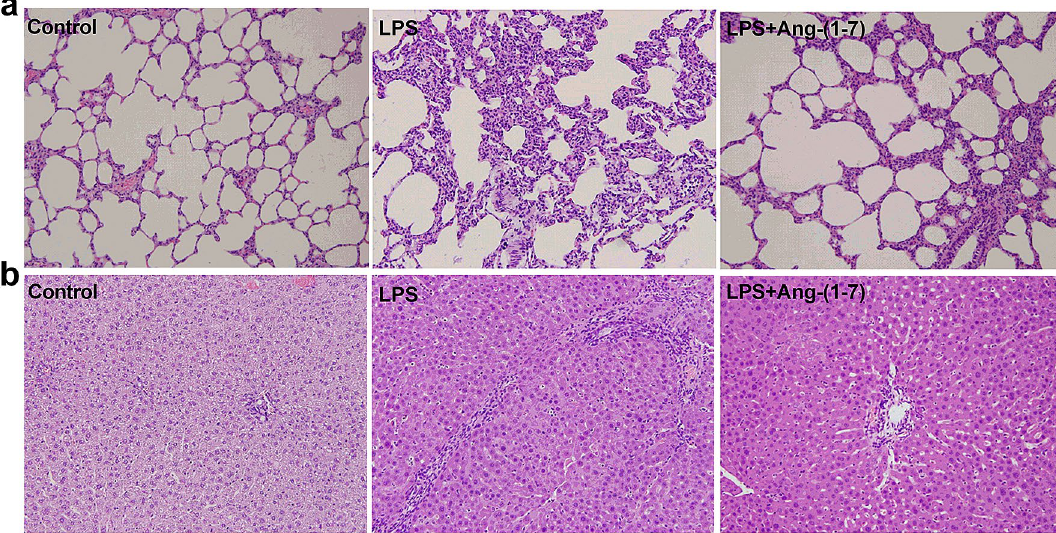
Figure 8. Histological analysis of lung and liver. Haematoxylin and eosin staining on ( a ) lung and ( b ) liver sections from rats infused with 0.9% NaCl (control), E. coli lipopolysaccharide (LPS, 10 mg/kg for 15 min), or